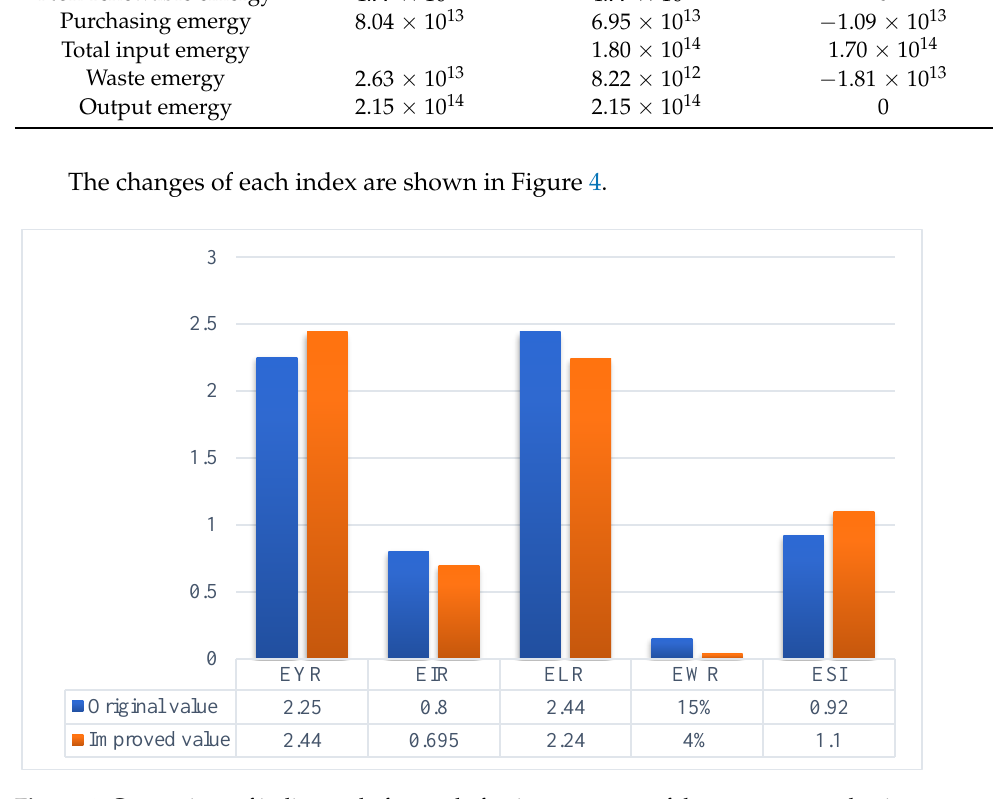
Figure 4. Comparison of indicators before and after improvement of the spur gear production pro-